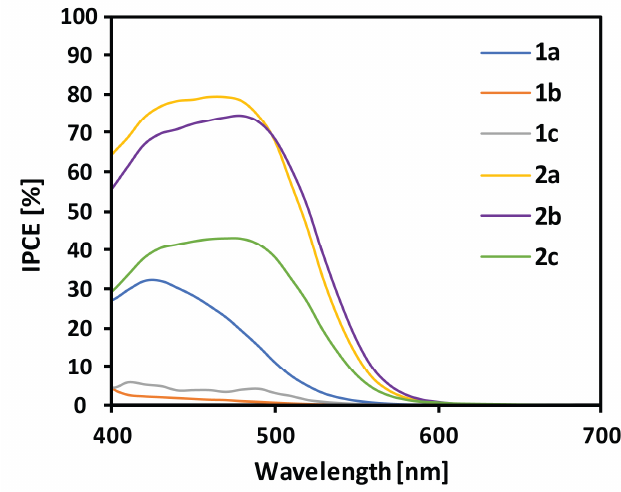
Figure 5. Internal power conversion efficiency chart.